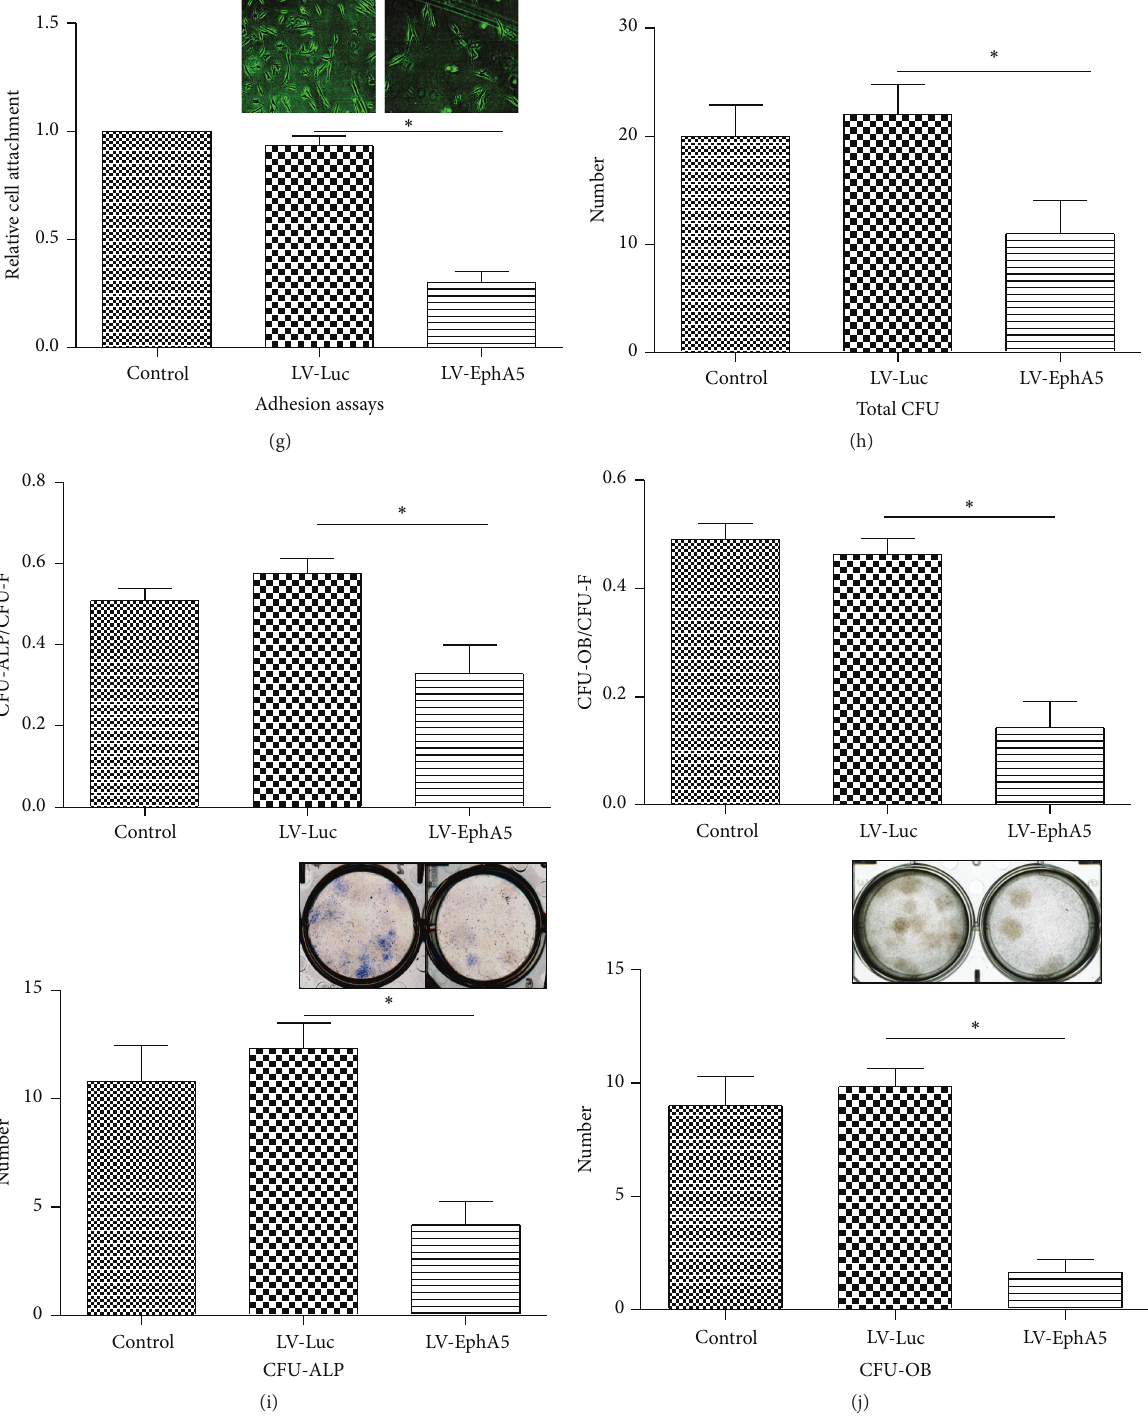
Figure 1: Forced expression of EphA5 inhibits osteoblast differentiation in hBMSCs. (a) Lentiviral constructs for transducing Luc and EphA5. (b) Schematic representation of the cell culture protocol. Adult hBMSCs were transduced with LV-Luc or LV-EphA5. ((c)–(f)) Quantitative analysis of mRNA expression of osteogenic markers at 7 days of osteogenic culture: (c) EphA5, (d) ALP, (e) Runx-2, and (f) ITGA5 ( 𝑛 = 4 ). The fold change of gene expression was normalized against the expression in cell cultures without LV transduction. ((c), lower) EphA5 protein levels were determined by western blot analysis. (g) Adhesion assays ( 𝑛 = 4 ). Images of cell attachment (upper). ((h)–(j)) CFU assays ( 𝑛 = 4 ). (h) Number of total colonies. (i) CFU-ALP positive rate (upper) and number of ALP-positive colonies (lower). Images of wells after ALP staining (middle). (j) CFU-OB positive rate (upper) and number of OB-positive colonies (lower). Images of wells after von Kossa staining